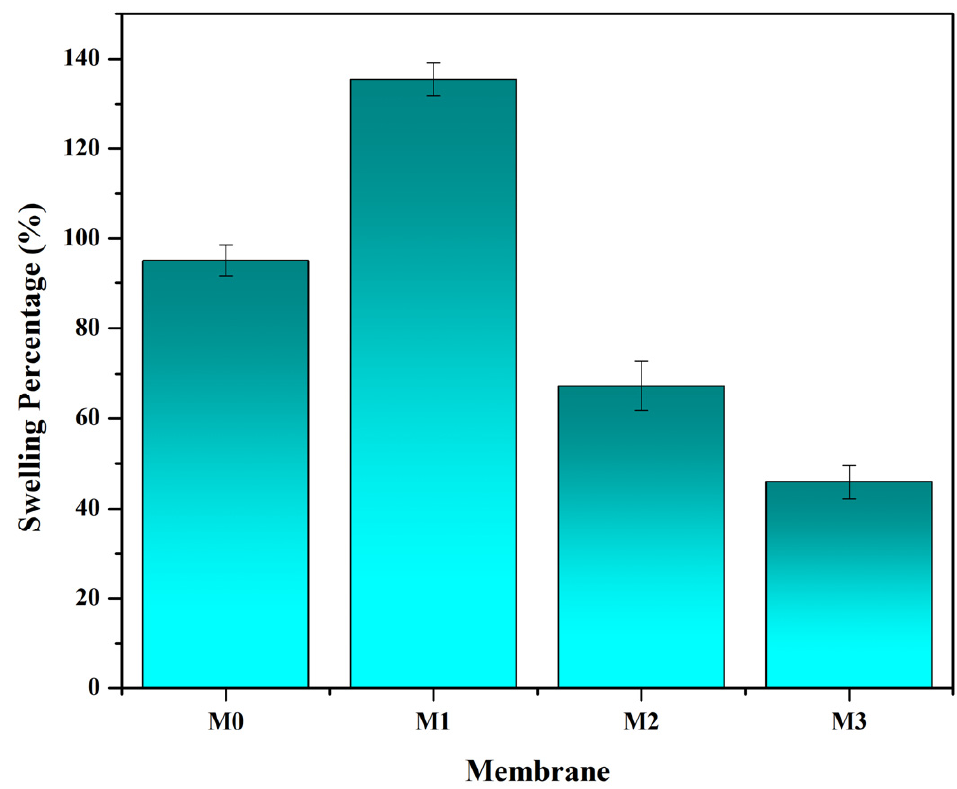
Figure 1. The effect of polymer composition on the membrane swelling. Membrane swelling was analyzed based on the ratio of the difference between the wet weight and dry weight of the membrane, as described in Equation (1).